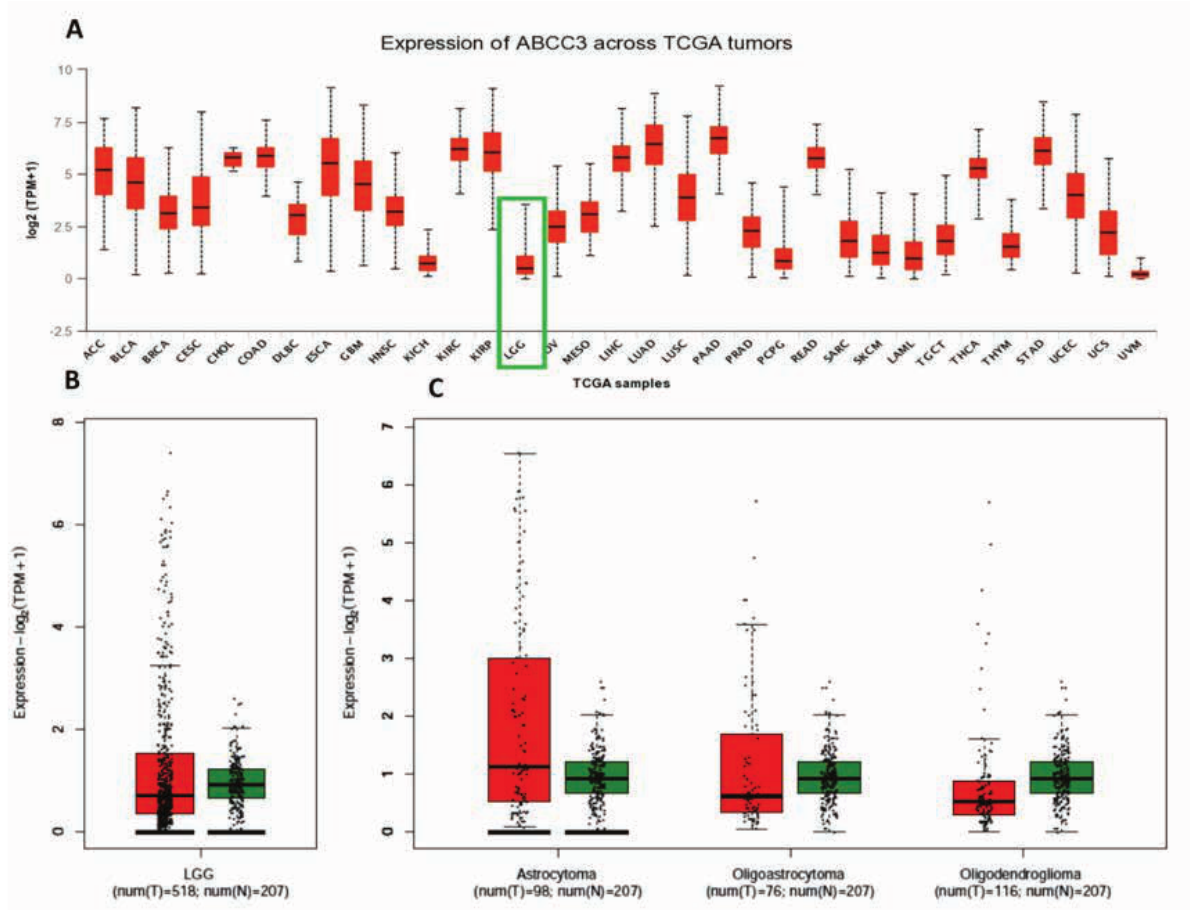
Figure 1: The expression of ABCC3 in human glioma tissues and other tumors (A: ABCC3 gene expression in various solid tumors and cor- responding normal tissues; B: Scatter plot of ABCC3 expression in glioma tissue and normal brain tissues; C: ABCC3 expression levels in different subtypes of